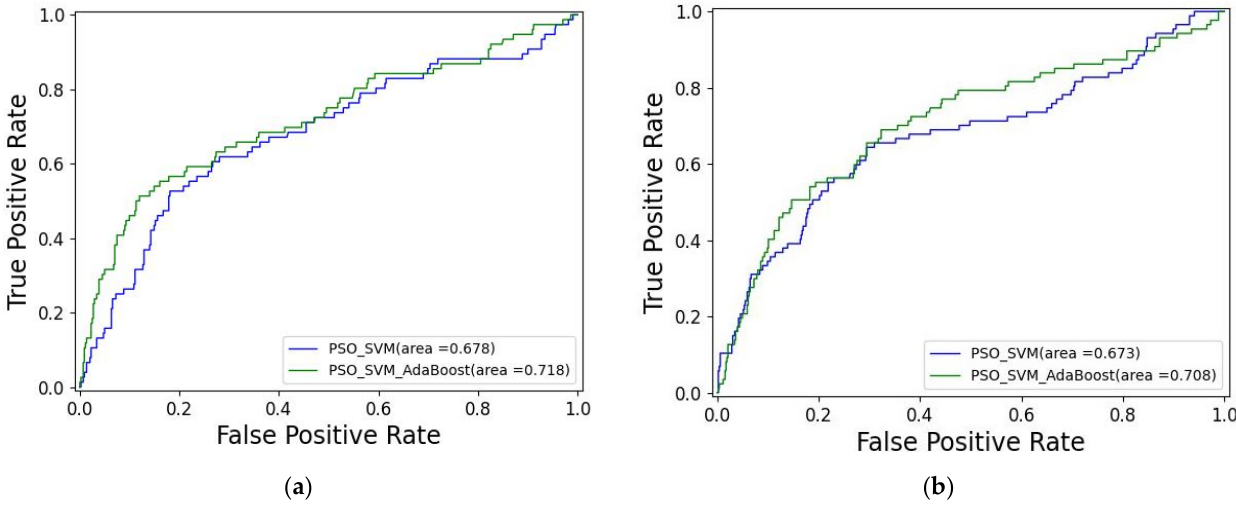
Figure 5. Comparison of ROC curves of the two datasets: ( a ) ROC curves of the first two classification methods without sampling of HIV-1 protease; ( b ) ROC curves of the first two classification methods without sampling of SRC protease.